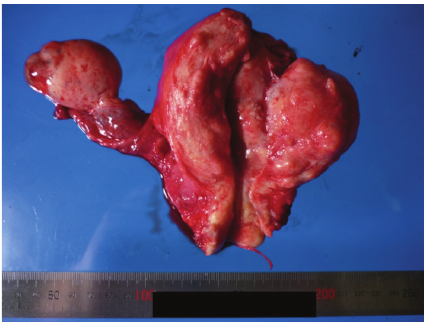
Figure 2: The surgical specimen. The endometrium appeared normal on gross examination.